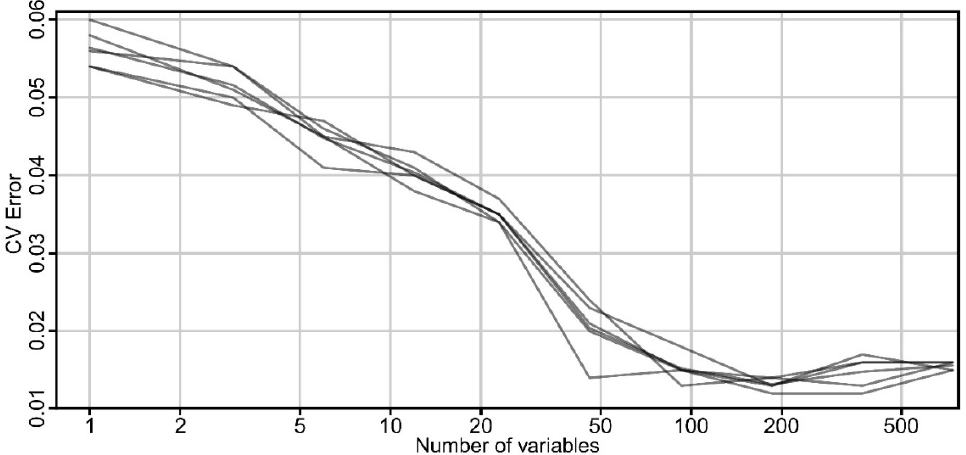
Figure 9. Plot of the CV error of 5 replicates for 10-folds rfcv with all the variables. (a high-resolution version can be found at https://doi.org/10.6084/m9.figshare.11798658)